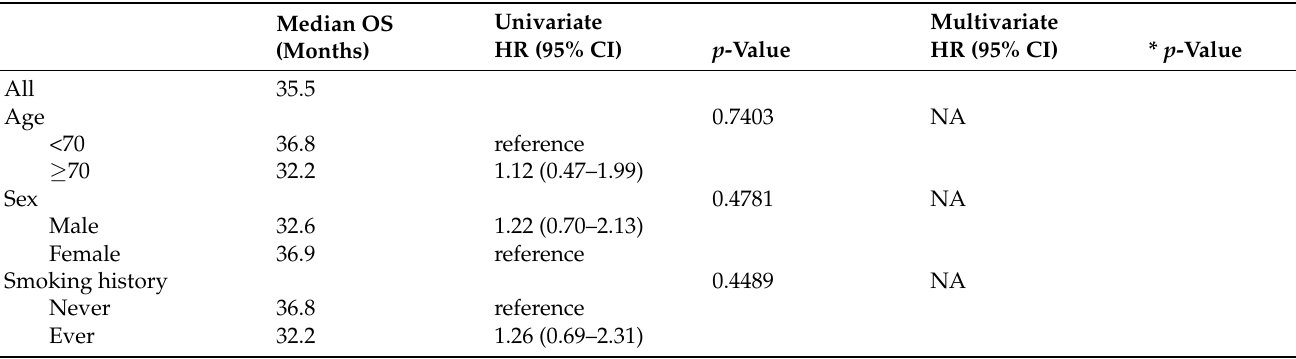
Table 4. Overall survival analyses results according to the clinicopathological parameters of all the study